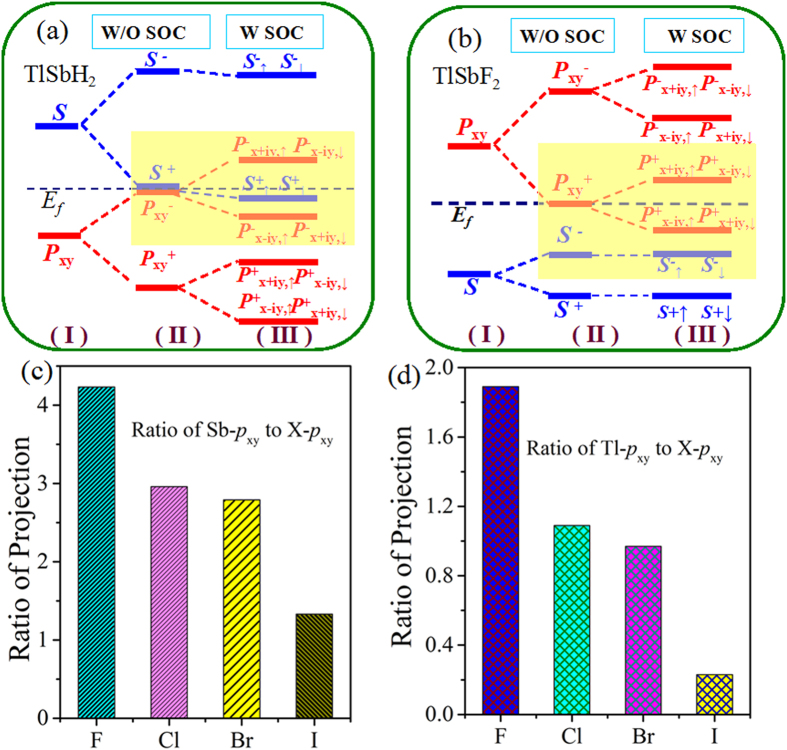
The evolution of atomic s and px,y orbitals without SOC and with SOC of (a) TlSbH2 and (b) TlSbF2. The horizontal blue dashed lines indicate the Fermi level. (c) The ratio of Sb-px,y to X-px,y component in the px,y orbital at the Fermi level. (d) The ratio of TI-px,y to X-px,y component in the px,y orbital at the Fermi level.